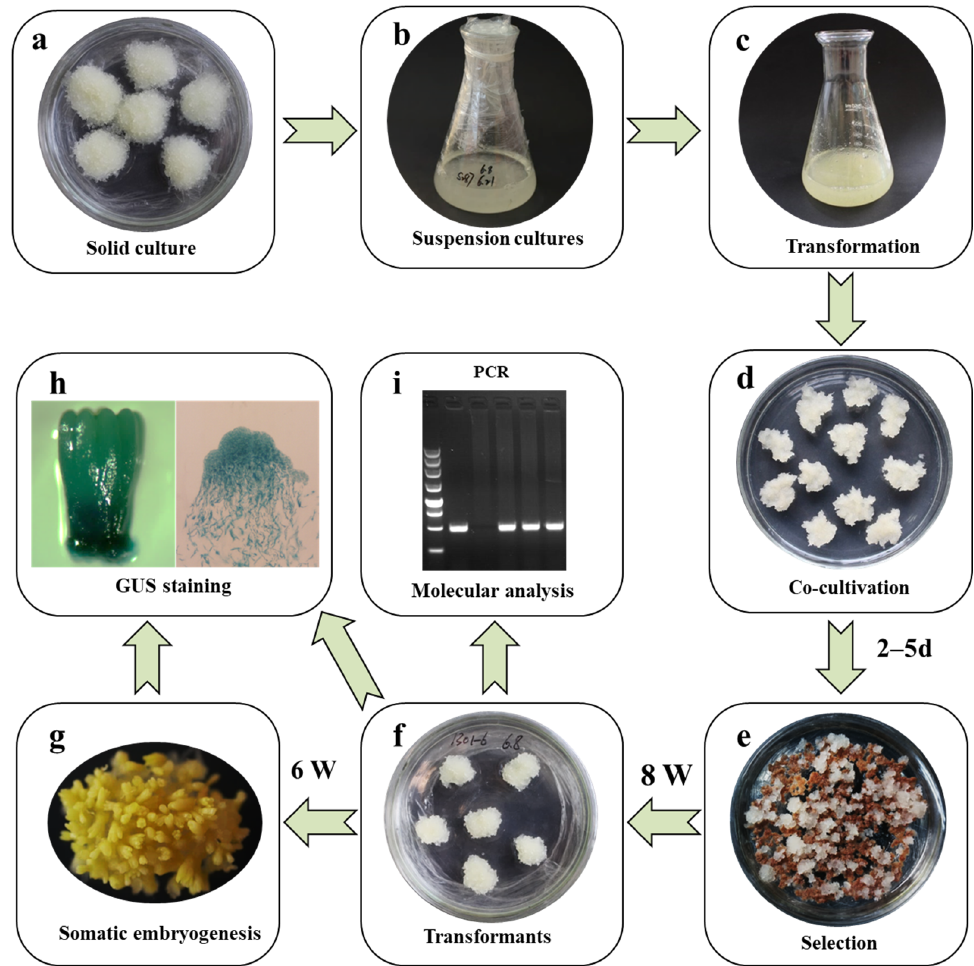
Figure 8. Overview of the simplified protocol for the genetic transformation of Larix kaempferi . ( a ) Embryogenic masses, ( b ) suspension cells, ( c ) suspension cells mixed with Agrobacterium (OD 600 = 0.05 – 0.1), ( d ) embryogenic masses co-cultivated with Agrobacterium for 46–120 h, ( e ) the selection of transformed embryogenic masses with cefotaxime (500 mg/L) and hygromycin (5 mg/L), ( f ) transgenic embryogenic masses, ( g ) somatic embryo maturation, ( h ) histochemical detection of GUS staining in somatic embryos, ( i ) molecular analysis of transgenic embryogenic lines.